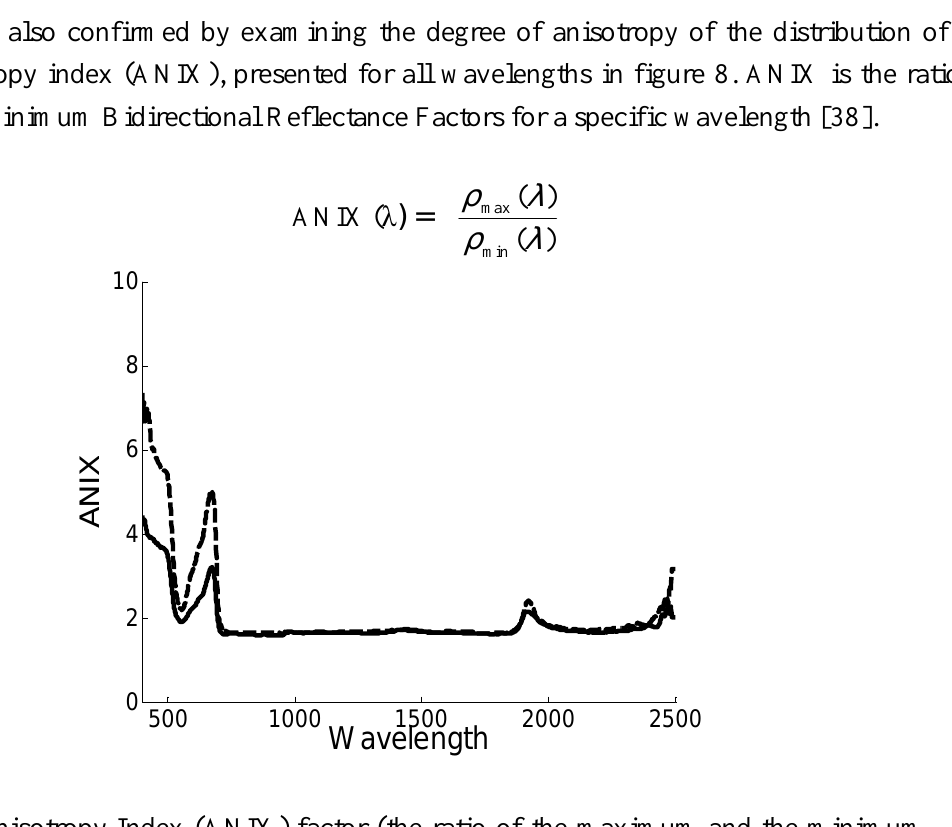
Figure 7 . Bidirectional Reflectance Factor of a Fagus sylvatica L. leaf in the principal plane for three wavelengths. Namely 550 nm, 850 nm and 1650 nm. The light source position is set at 0° azimuth and 30° zenith (left graph) and 0° azimuth and 60° zenith (right graph). The sensor is on the principal plane with minus zenith values corresponding to forward scattering. The legend is the same for both graphs.